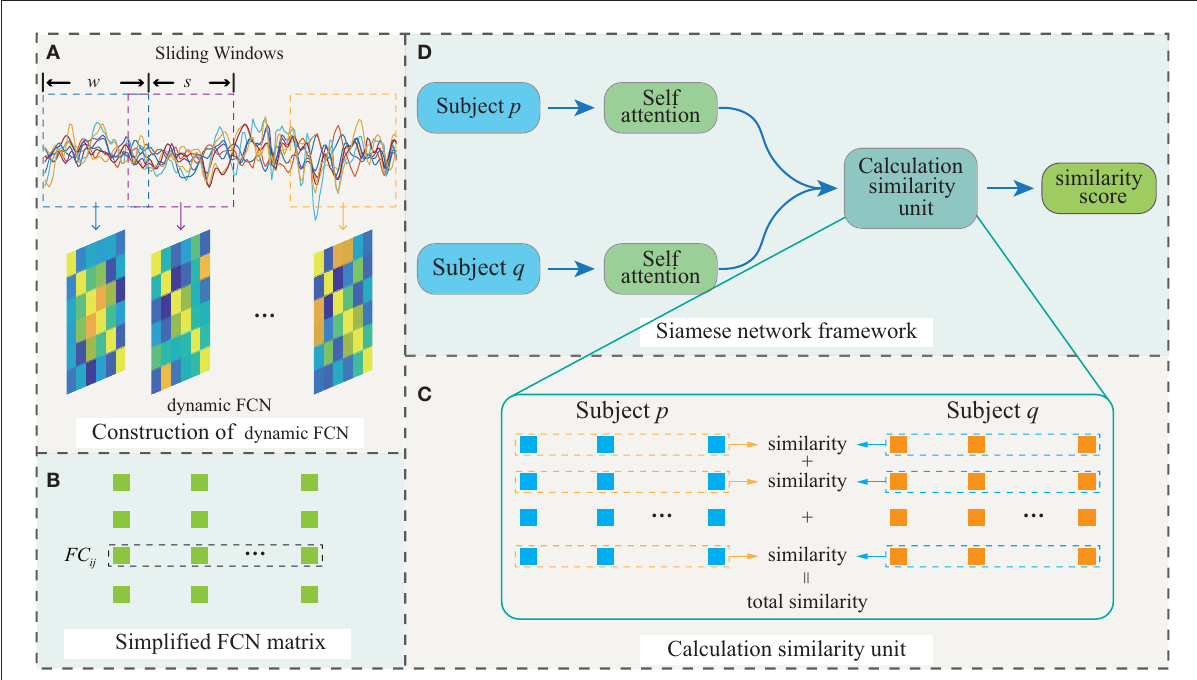
FIGURE1 The framework of the proposed model. (A) Construction of dynamic FCN. (B) Simplified FCN matrix. (C) Calculation similarity unit. (D) Siamese network